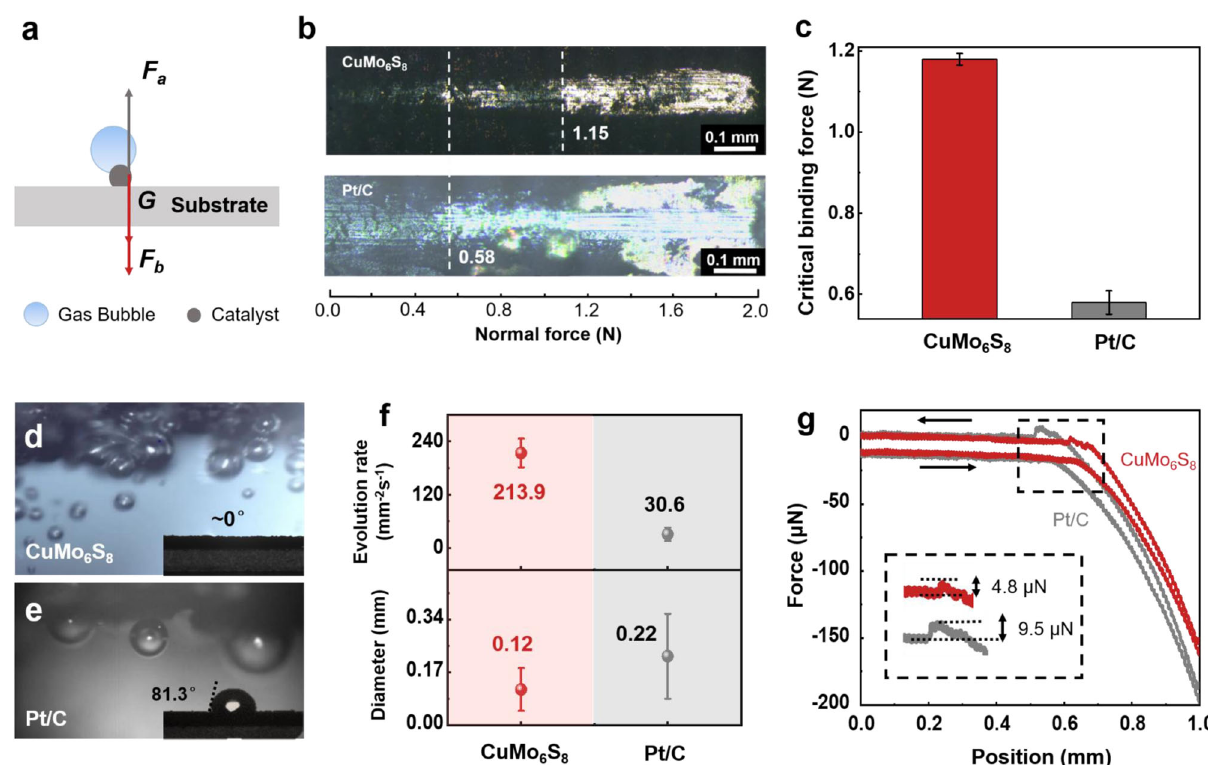
Fig. 4 | Strong interfacial binding force and small electrocatalyst-gas bubble interfacial adhesion force.a Force analysis model of gas bubbles attached on the electrode. F a , F b , and G represent the electrocatalyst-bubble interfacial adhesion force, the electrocatalyst-support interfacial binding force, and the gravity of electrocatalysts, respectively. b The photos of micro-scratches of CuMo 6 S 8 (top), Pt/C (bottom) catalyst layers adhesive on Cu foils. The dotted lines represent the critical adhesive forces corresponding catalysts. c The statistical data of critical